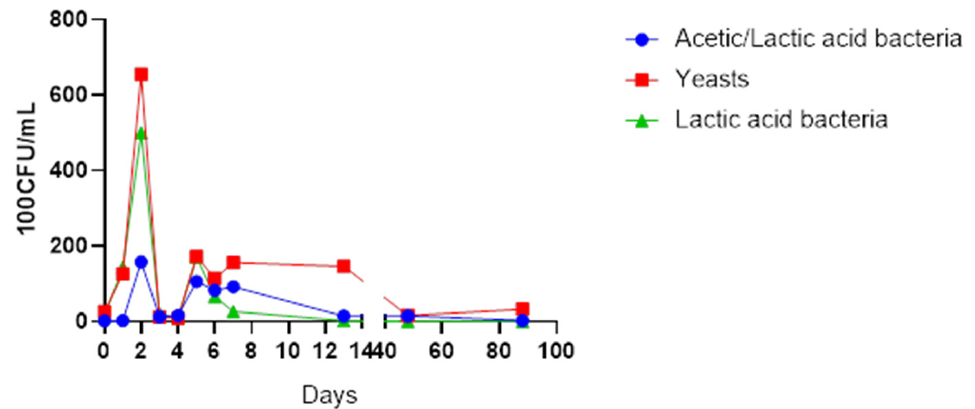
Figure 1. The changes in yeast and selected bacterial counts during spontaneous fermentation of cactus fruit juice.